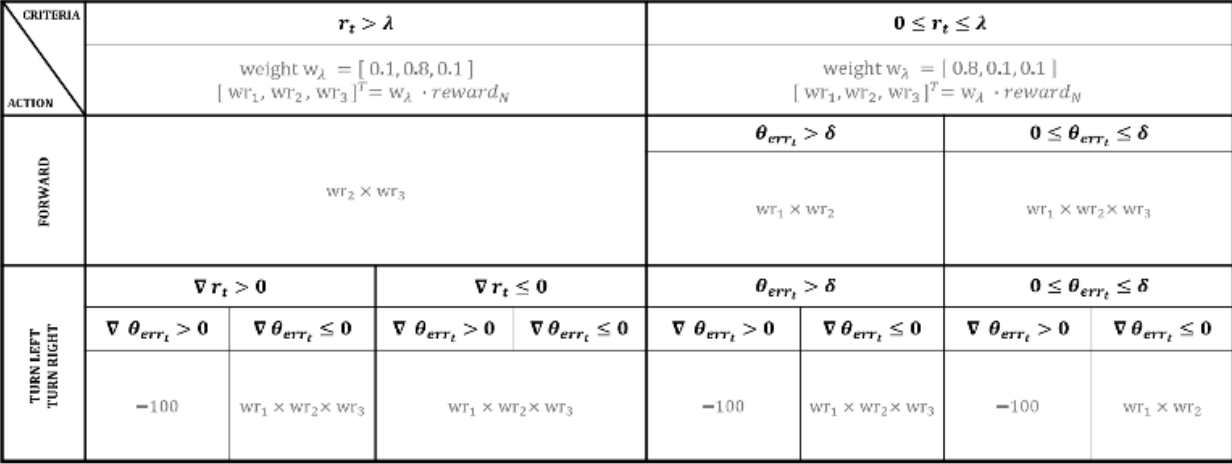
. Figure 14. Reward discrimination table describing step rewards per action reward S 𝑆